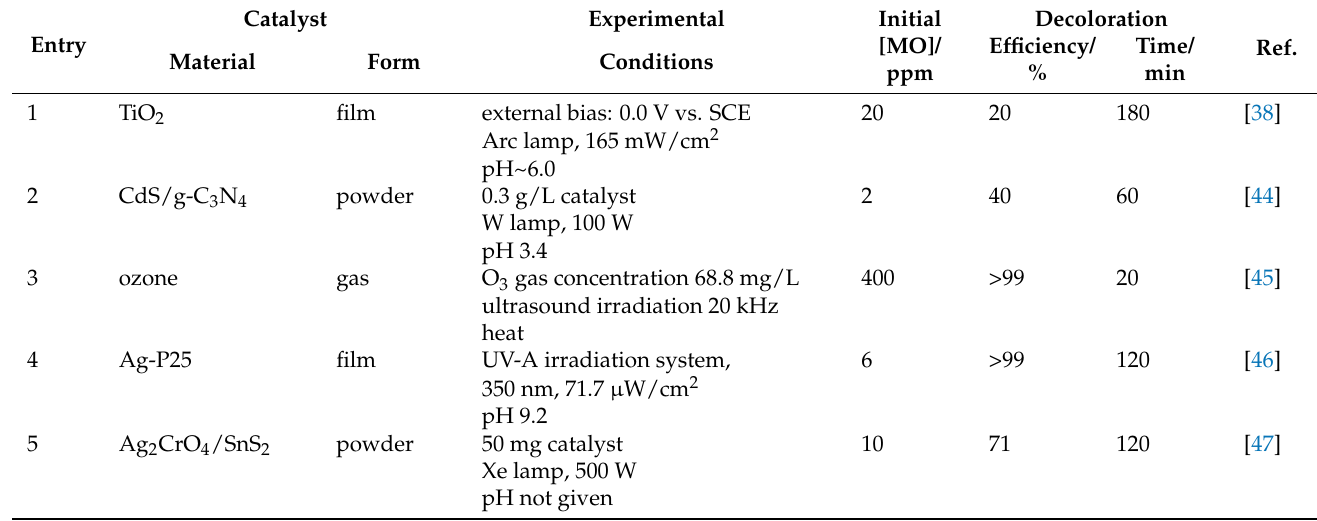
Table 1. Discoloration efficiency of MO dye by different catalyst